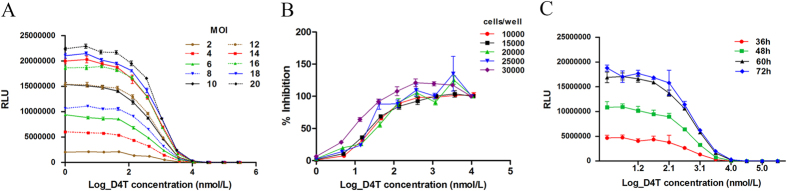
Optimization of MOI, cell density and detection time of phenotypic susceptibility testing.(A) Determination of the optimal MOI. (B) Determination of the optimal cell density. (C) Optimization of detection time. An antiviral drug D4T was used and the D4T concentrations are presented in the log scale. RLU, Relative luciferase activity unit.